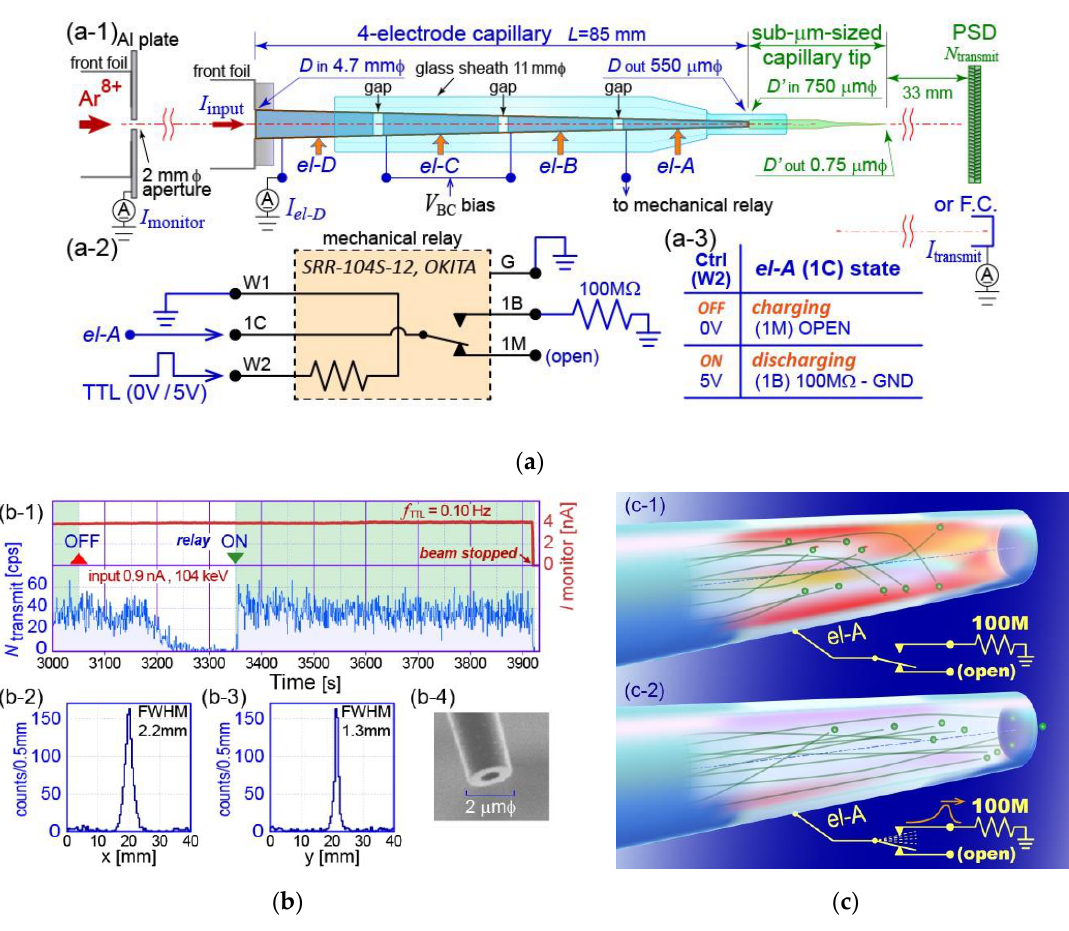
Figure 11. ( a ) Experimental arrangement. The tandem capillary consisted of a sub- µ m-sized capillary tip and a four-electrode capillary; ( b ) time evolution and the profiles of the transmitted beam through the outlet of 0.75 µ m φ ; ( c ) explanation of the active discharging. (Figures reprinted from [30], with the permission of AIP Publishing).